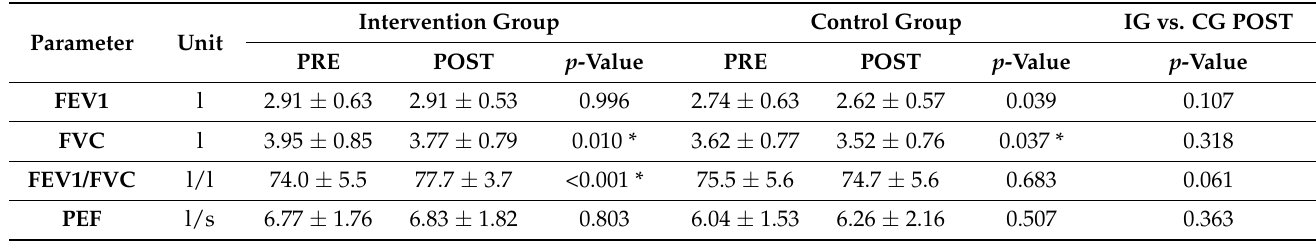
Table 3. Pulmonary function testing. IG and CG